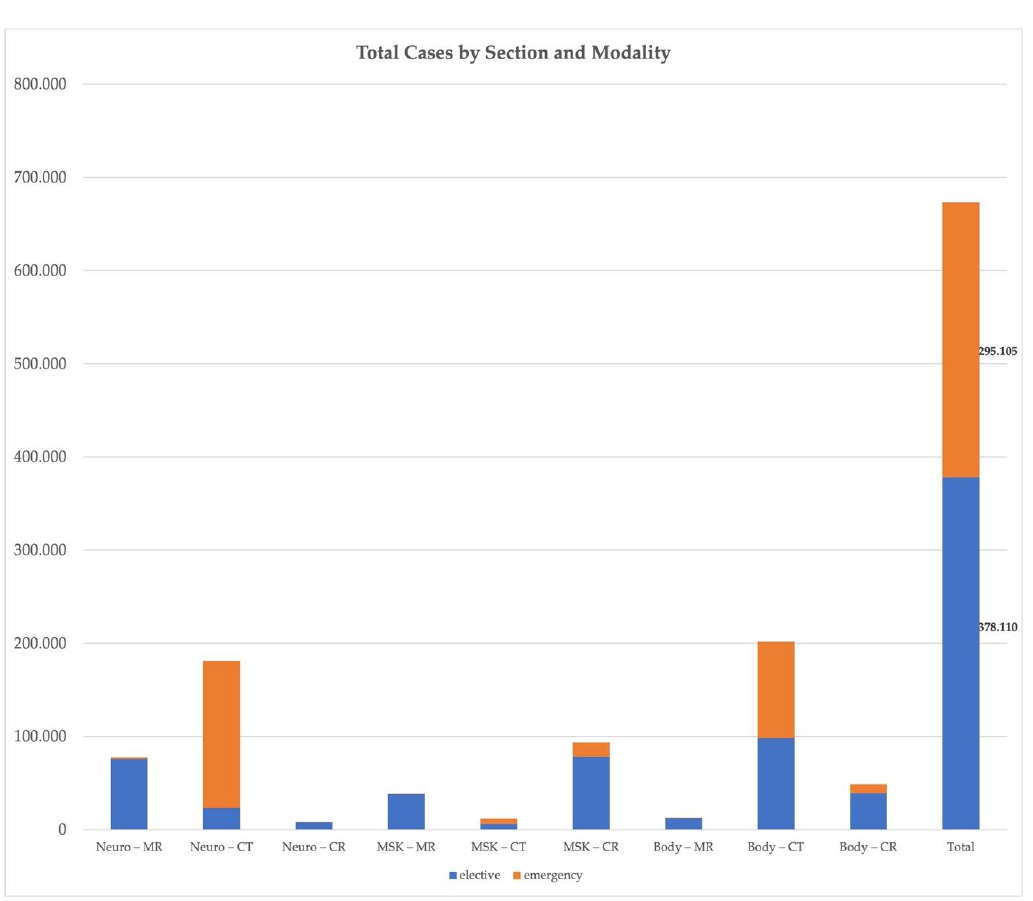
Figure 3. Total cases 2021. Total caseload of the elective (blue) and emergency (orange) teleradiology services provided by TMC in 2021 according to sub-specialization and modality.